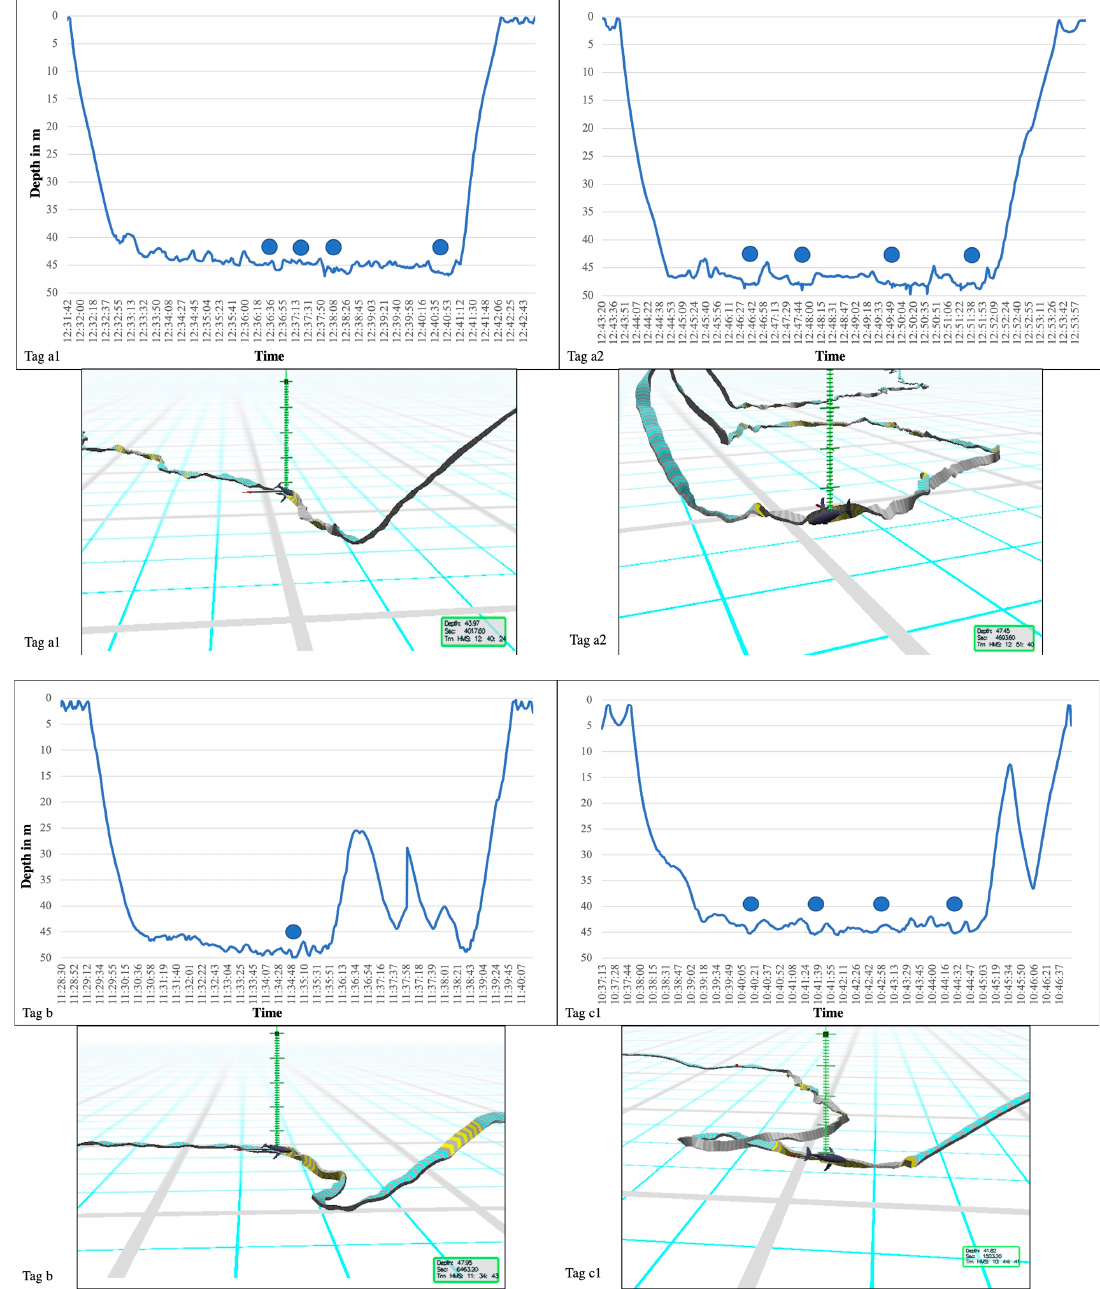
Figure 4. A series of depth profiles between surface intervals for three different tagged humpback whales (tag a, b and c) performing sand rolling and their corresponding pseudo-track with pitch. The 14 sand rolls are indicated with a dot along the depth profile.